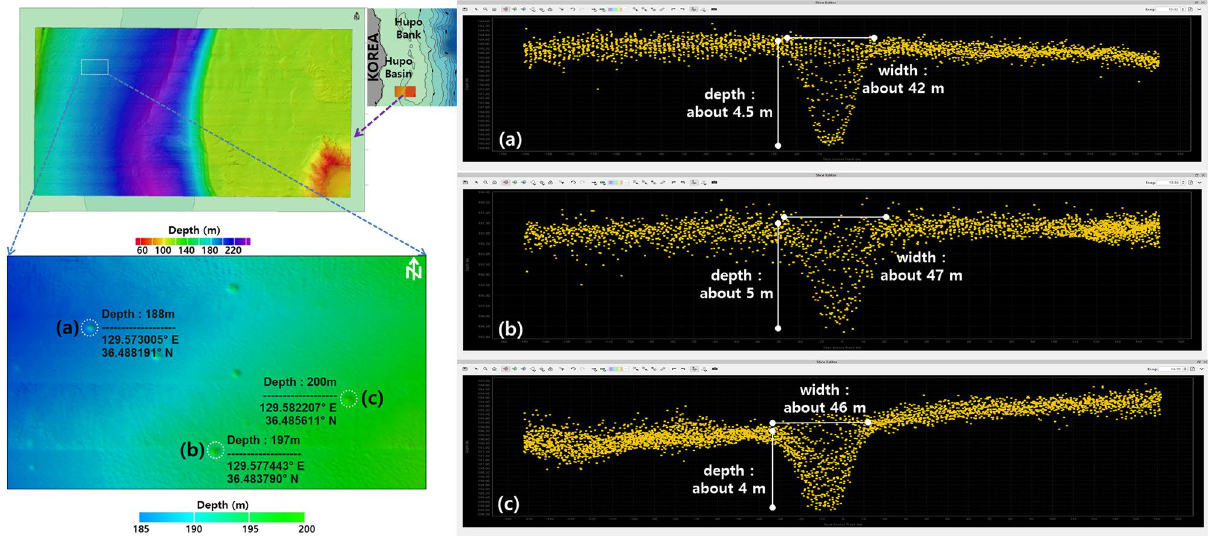
Figure 10. Bathymetry and pockmarks in the southern part of the Hupo Basin (Left) and various sizes of pockmarks in the survey area (Right). These figures were generated using the Surfer software (https:// www. golde nsoft ware. com/), the Hips & Sips software (http:// www. teled yneca ris. com/), and the Fledermaus software (http:// www. qps.